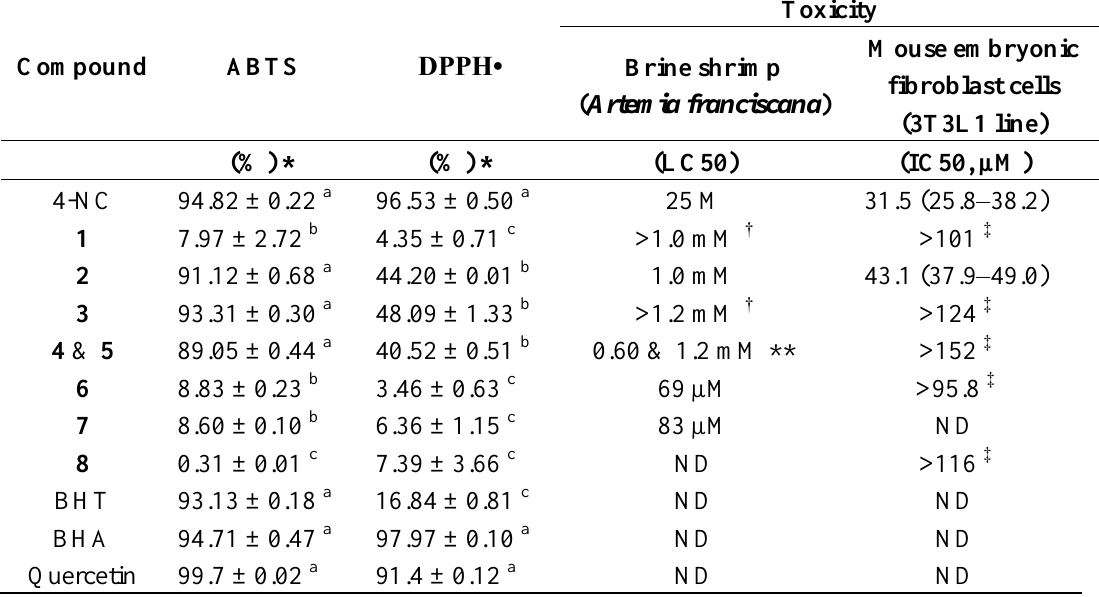
Table 1. Free radical scavenging activity and cytotoxicity of 4-NC, derivatives of 4-NC and commercial antioxidant food additives BHA and BHT.